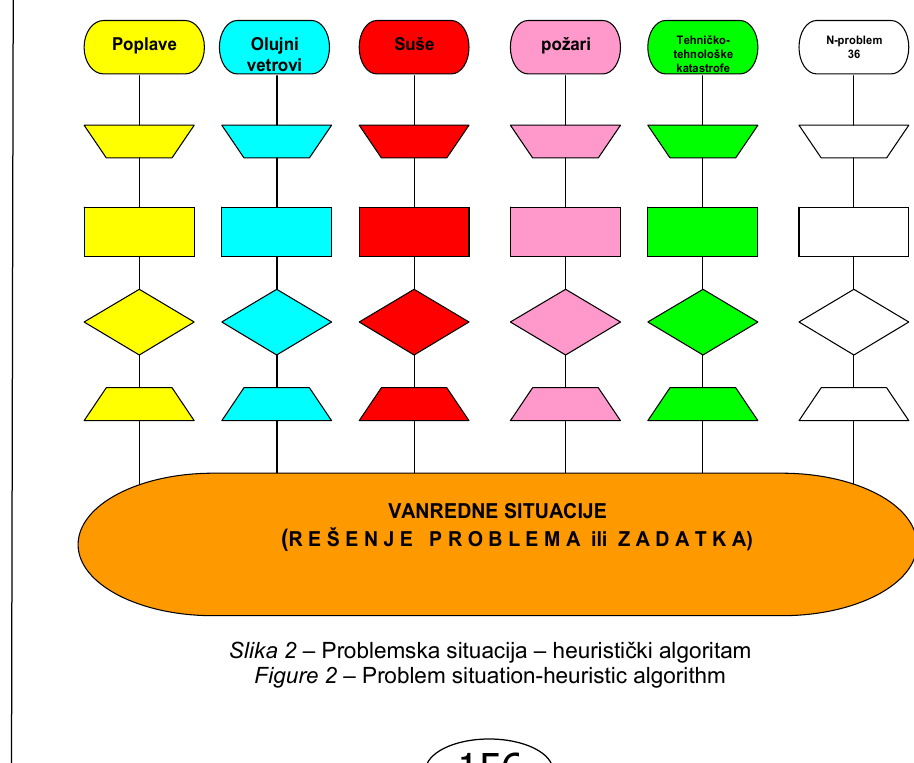
Figure 1 – Representation of different emergency situations in Serbia and Montenegro (1989-2006). Taken from the Final Report on the risks of the countries of the South East Europe Initiative for risk management of emergencies in SEE-SEEDRMI, July